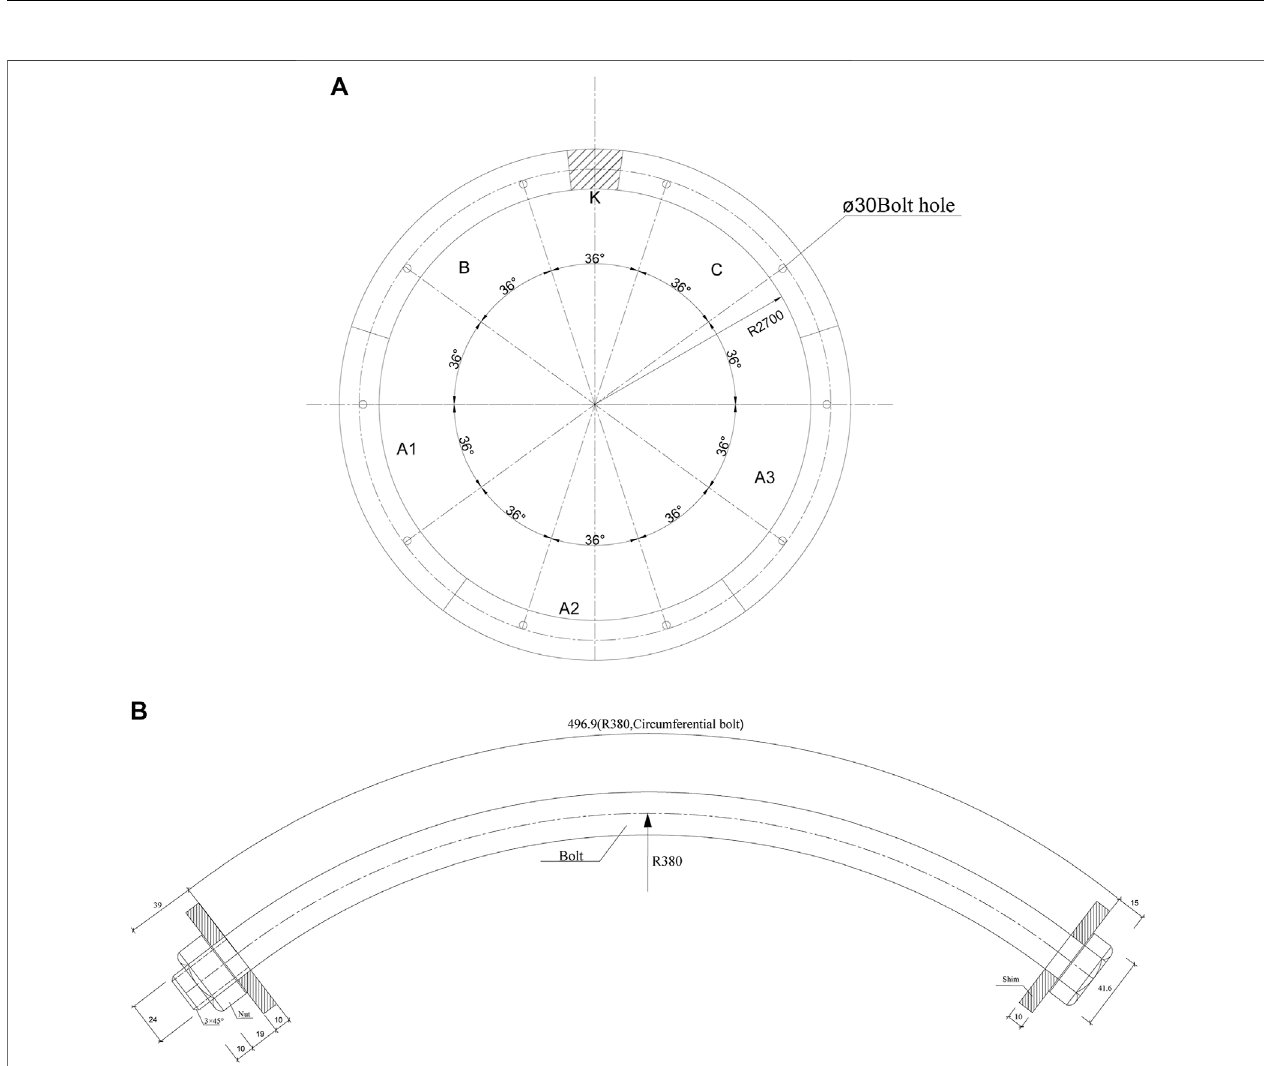
FIGURE 3 | (A) The layout of the circumferential bolts and (B) the ring bolt detail of the shield tunnel in an engineering section.